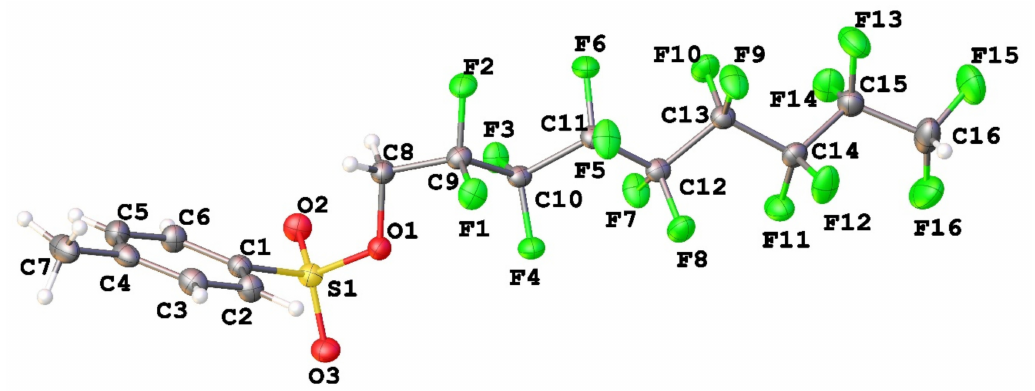
Figure 6. Molecular structure of 4 . Atoms are presented as thermal ellipsoids.